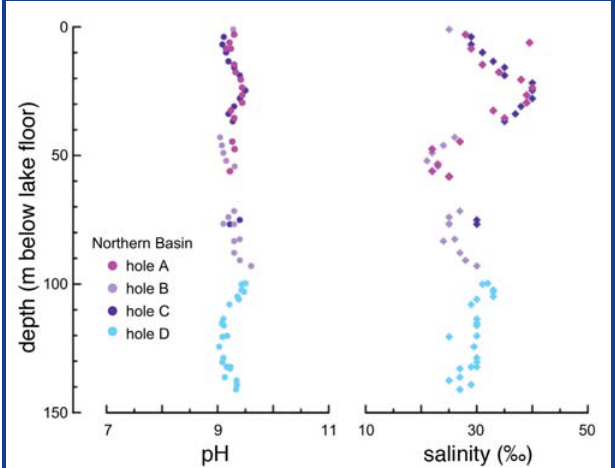
Figure 9. pH and salinity pore water profiles from the Northern Basin analyzed in the on-land lab. Both profiles show distinct “positive” and “negative” fluctuations with regard to recent geochemical state of Lake Van. Observed gradients can only exist over the given temporal (10–100 kyr) and spatial (>20 m) scales if the vertical diffusive transport is suppressed in comparison to diffusive exchange in a continuous and connected pore-water domain. At Ahlat Ridge (not shown), the pore water pH decreases from nearly 10 to 7 in the lowermost 40 m of the cores. According to preliminary results in same depth range, dissolved Ca and Mg concentrations increase continuously—most probably in response to the lower pH—toward the bedrock.